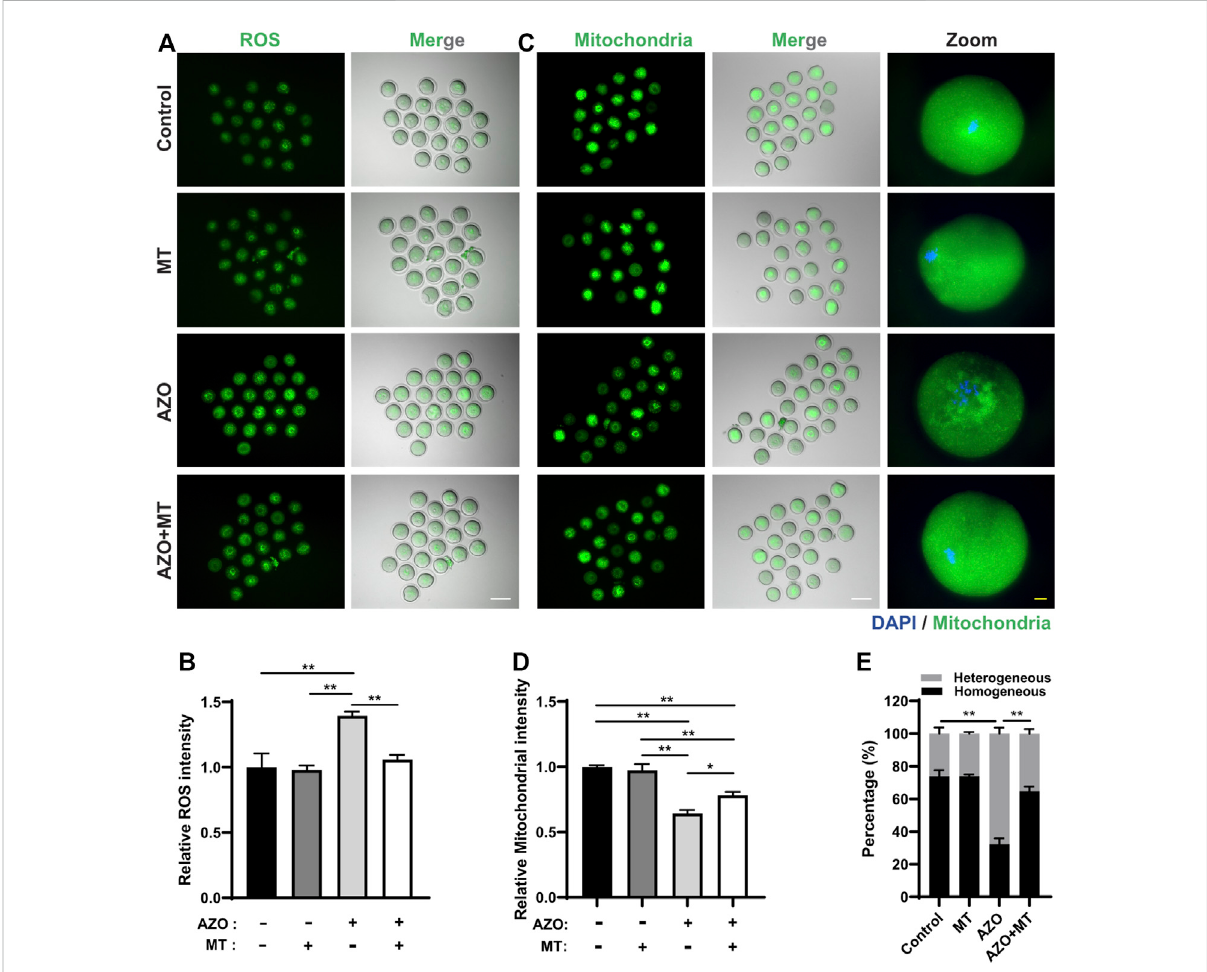
FIGURE 7 Melatonin protects against oxidative stress and mitochondrial dysfunction induced by azoxystrobin (AZO). Oocytes were cultured for 8 h inthe absence ( − ) or presence (+) of AZO and melatonin (MT) during meiotic maturation. (A) Representative images of live oocytes stained with DHR-123. Scalebar,100 μ m. (B) ROSintensity ofoocytesincontrol,MT,AZO,andAZO+MTgroupsaredetermined. (C) Representative imagesofliveoocytes stained with Mitotracker. Scale bar, 100 μ m (white). Enlarged images of oocyte with homogeneous distribution in the control, MT, and AZO + MTgroupsandoocytewithheterogeneousdistributionintheAZOgroup.Scalebar,10 μ m(yellow). (D) Mitochondrialintensityofoocytesincontrol, MT, AZO, and AZO + MT groups are determined. (E) Percentage of oocytes with homogeneous or heterogeneous mitochondrial distribution. Data are expressed as mean ± SEM from fi ve independent experiments. * p < 0.05, ** p <